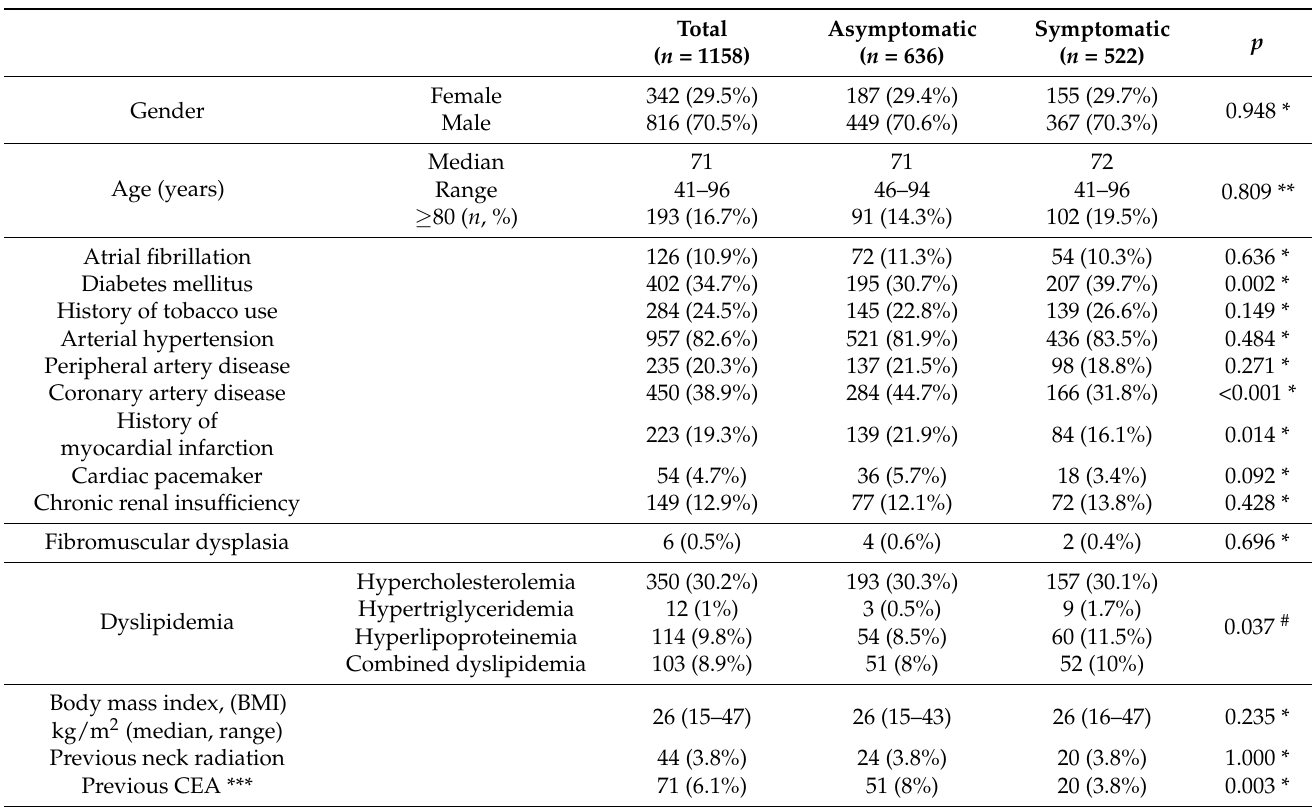
Table 2. Risk factors.